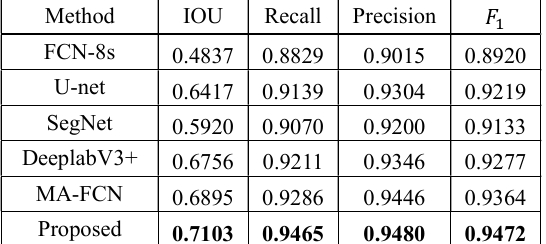
Table 2 . Accuracy evaluation results of different models on the Inria dataset.